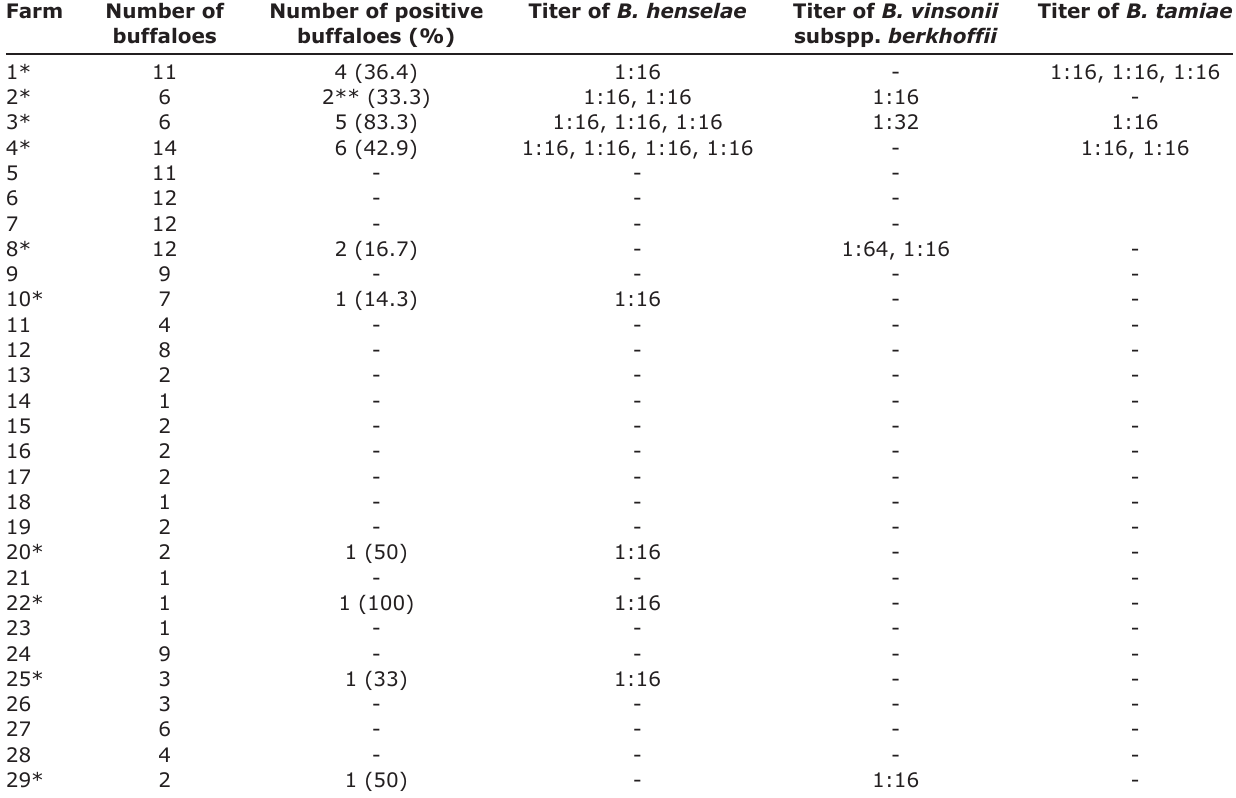
Table-3: Herd seroprevalence and titer of antibodies against B. henselae, B. vinsonii subspp. berkhoffii , and B. tamiae in positive buffaloes. Farm Number of